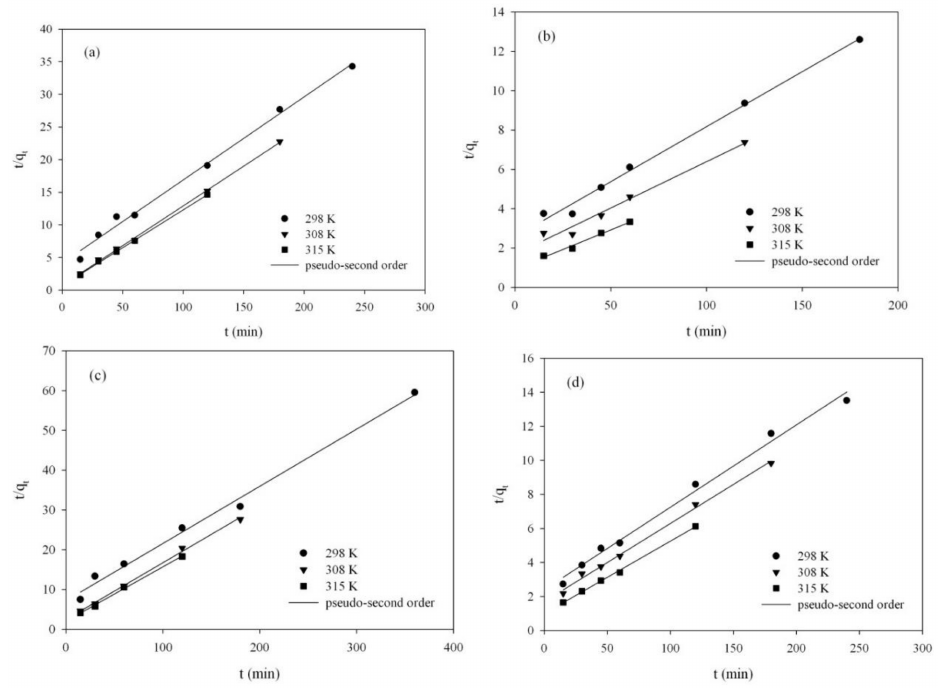
Figure 6. Pseudo-second-order kinetic model for RB adsorption onto ST-A ( a ) and CWZ-22 ( c ), and for AY17 adsorption onto ST-A ( b ) and CWZ-22 ( d